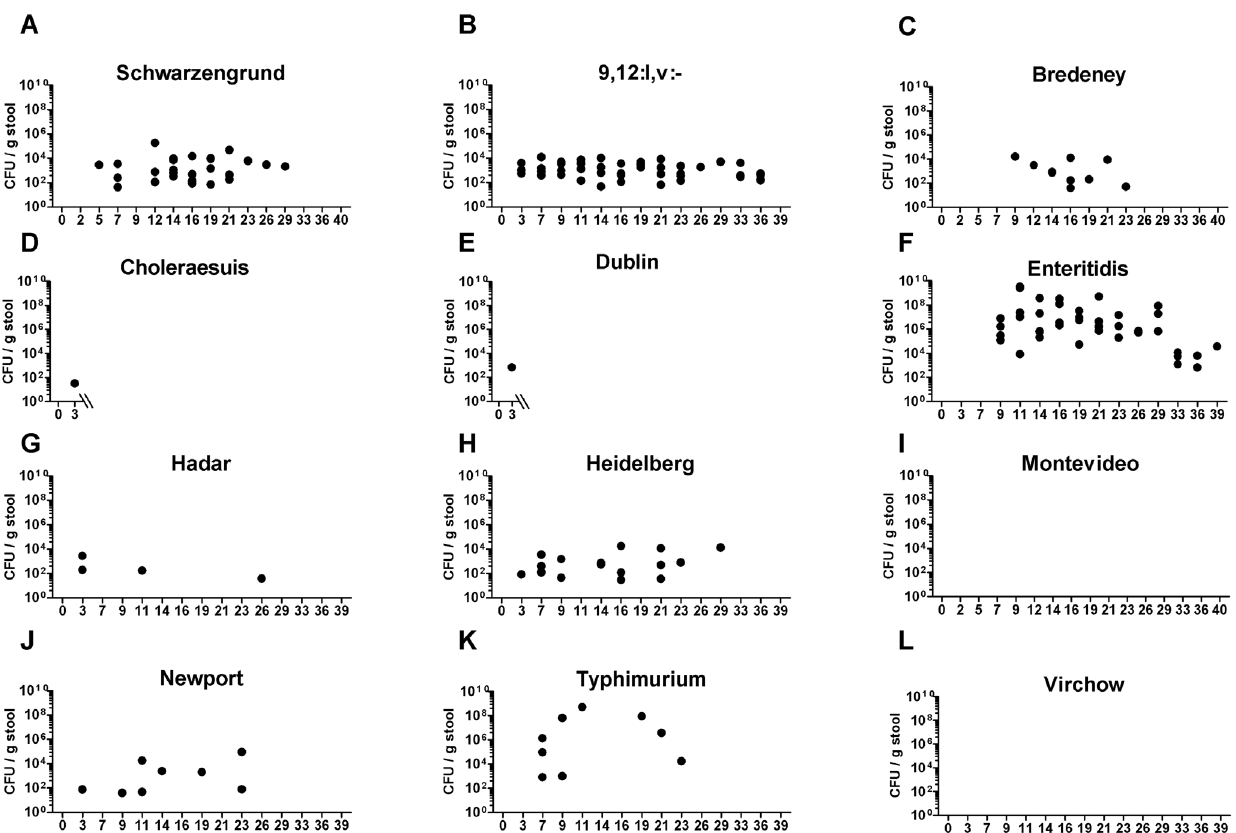
Figure 5. Persistent infection of iNTS strains in the mouse model. Following challenge with , 5 6 10 3 CFU of the bacteremic strains, fecal pellets were collected from the C3H\HeN mice at the indicated time points during 40 days (or until the animal was sacrificed). Pellets were weighed, homogenized in PBS and plated onto XLD-agar plates to determine the number of CFU/g stool. Shedding of S. Choleraesuis (D) and S. Dublin (E) is shown only until 3 days p.i., as the mice had to be euthanized. Dots represent independent CFU counts in pellets of individual mice.